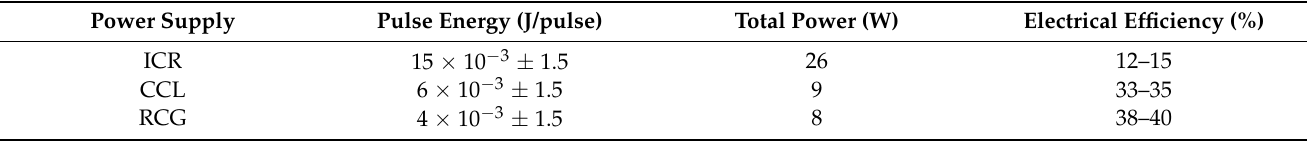
Figure 17. H 2 O 2 production efficiency in ICR, CCL, and RCG reactors. Table 1. Pulse energy and electrical efficiency for the proposed power